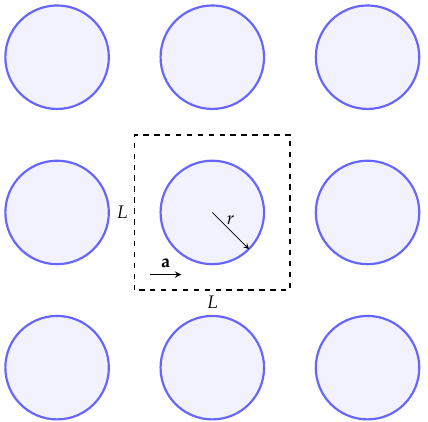
Figure 3. A schematic depiction of the problem studied in [83]. The unit periodic cell is a square with size L containing a cylinder of radius r in the center of the square. The fluid around the cylinder is set in motion by acceleration a directed to the